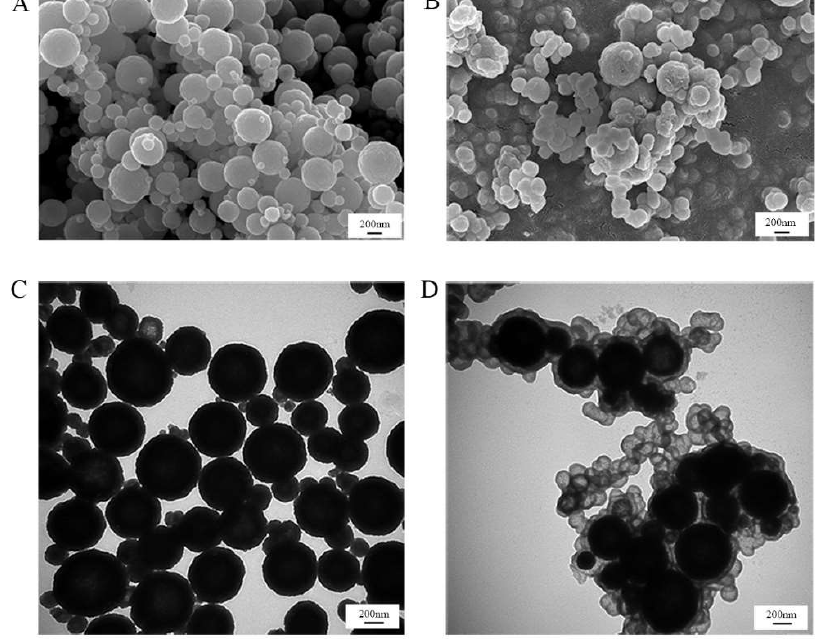
Figure 5. SEM and TEM images of Fe 3 O 4 ( A , C ) and encapsulated glucose oxidase ( B , D ).